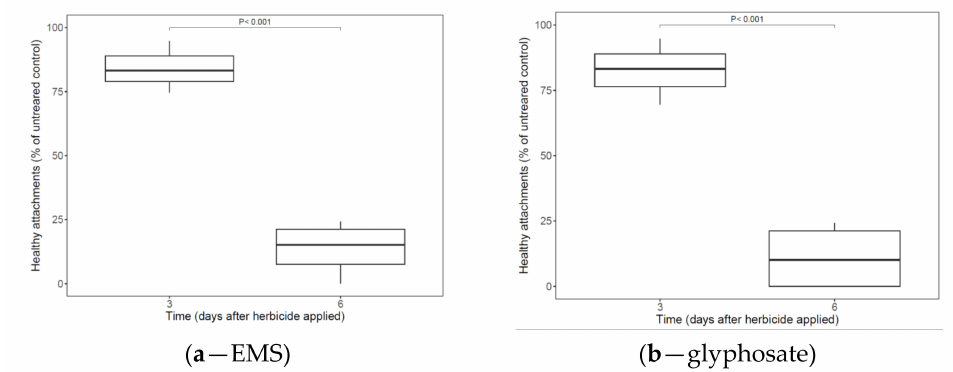
Figure 1. Healthy attachments of P. aegyptiaca compared with non-treated control in cabbage grown hydroponically in polyethylene bags. Ethametsulfuron-methyl (EMS, a ) and glyphosate ( b ) were applied to the cabbage foliage after P. aegyptiaca attachment. Means were compared using a paired t -test ( p < 0.05 ); the numbers in the figure represent p -values.